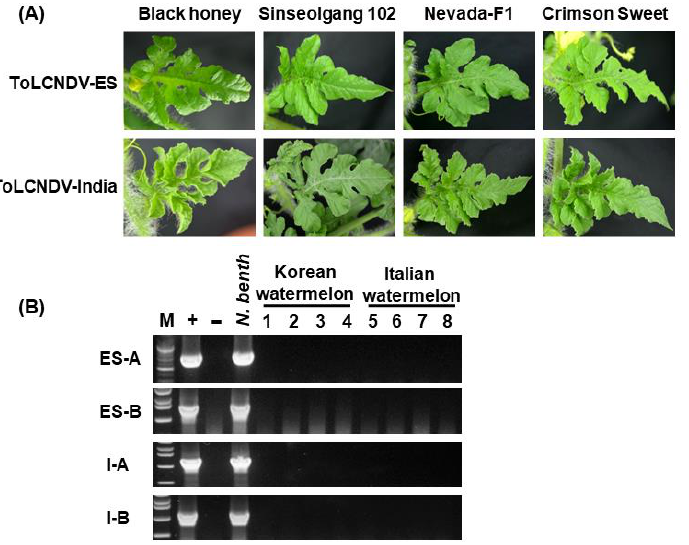
Figure 5. Different watermelon cultivars inoculated with two ToLCNDV isolates via agroinoculation. ( A ) Normal phenotype of inoculated plants. Blackhoney and Sinseogang102 as Korean watermelon, Nevada-F1 and Crimson Sweet as Italian watermelon. ( B ) PCR results using specific primers for each DNA component of two ToLCNDV isolates. N. benthamiana was used to test positive with ToLCNDV. Lane M: ladder; Lane +: positive control; Lane − : negative